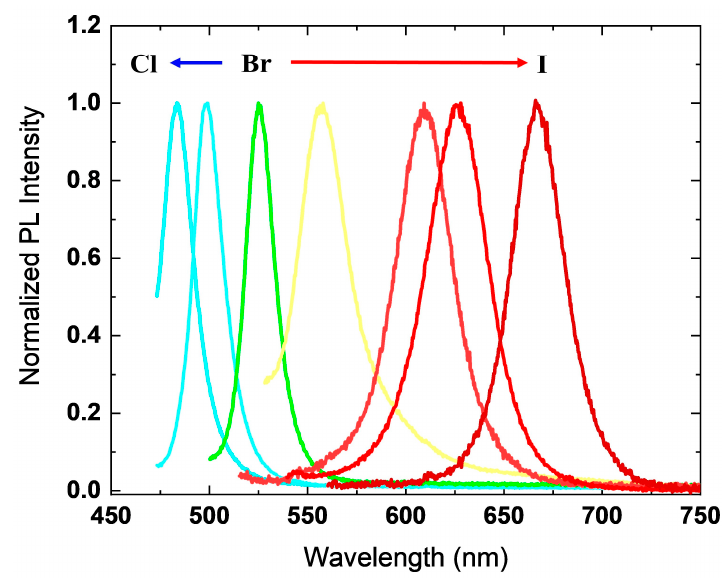
Figure 1. Photoluminescence (PL) spectra of a series of perovskite nanocrystals (PNCs) with different halide compositions under a 450-nm blue light-emitting diodes (LED) excitation.